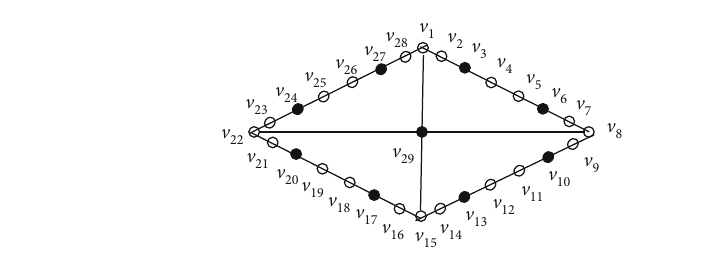
Þ = m b s /3 c + 1 = 9 7,4